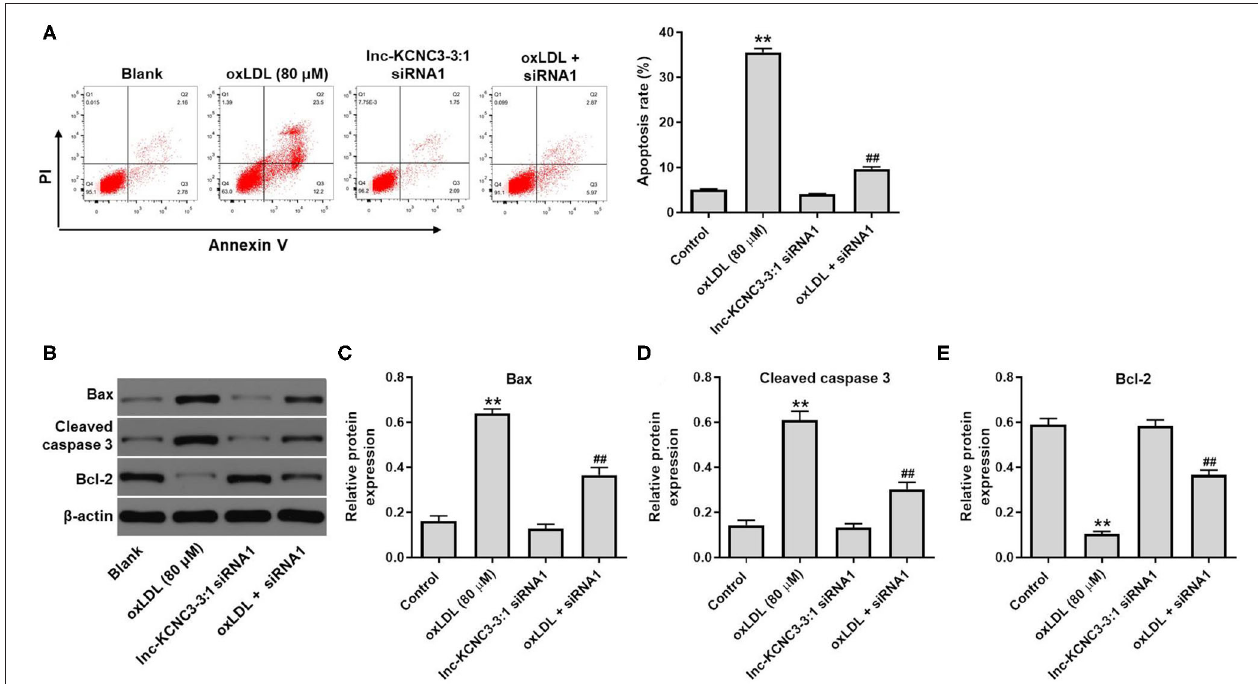
FIGURE 4 | Knockdown of lnc-KCNC3-3:1 reversed oxLDL-induced apoptosis of HUVEC. HUVECs were transfected with lnc-KCNC3-3:1 siRNA1 for 6h s. Then, cells were treated with 80 µ g/mL of oxLDL for 24h. (A) Flow cytometer assay was used to analyze the apoptosis of HUVEC. (B–E) Western blot was performed to measure the expressions of Bax, Bcl-2 and cleaved caspase 3 in HUVEC cells. ** P < 0.01 compared with control group. ## P < 0.01 compared with the oxLDL (80 µ M) group, n = 3.